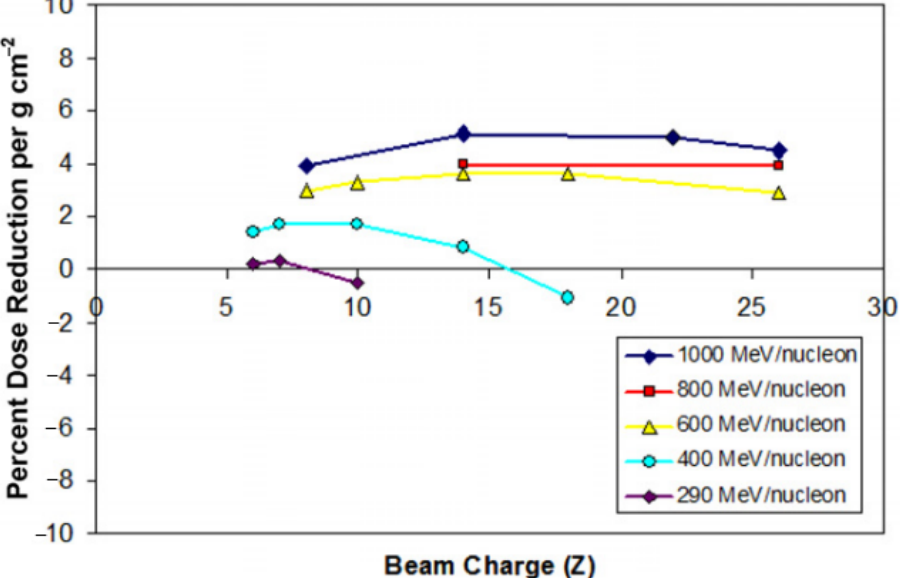
Figure 3. Percent dose reduction per areal density for the same shield (2.83 g cm 2 polyethylene target) against different ion/energy combinations.